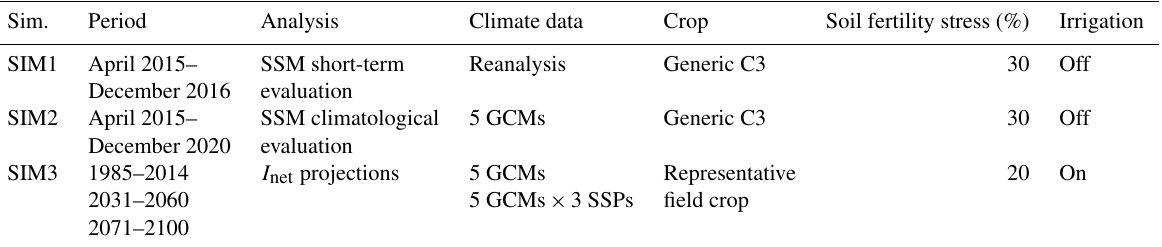
Table 2. Description of the different simulations with regard to the simulation periods, analyses, climate data, crop characteristics, soil fertility stress, and the activation of the irrigation (On/Off). Sim. Period Analysis Climate data Crop Soil fertility stress (%) Irrigation